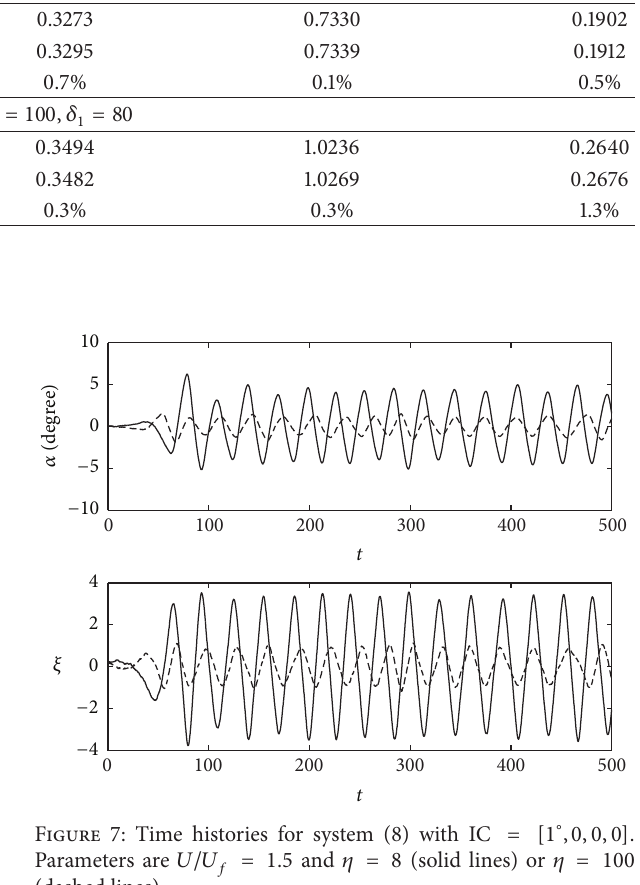
Figure 6: The distribution functions for the three extremes of 𝐴 and = 1 , 𝛿 = 100 , and 𝛿 = 80 . 𝐻 with 𝑈/𝑈 𝑓 0 1